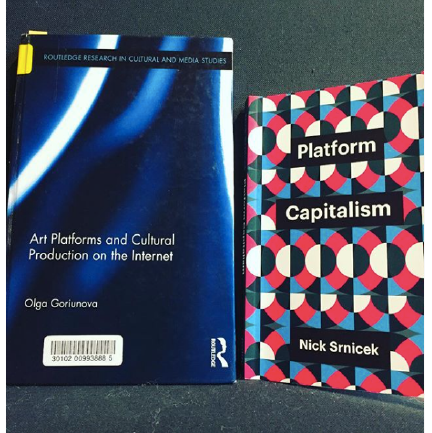
Figure 1 | Book Covers of Art Platforms and Cultural Production on the Internet by Olga Goriunova and of Platform Capitalism